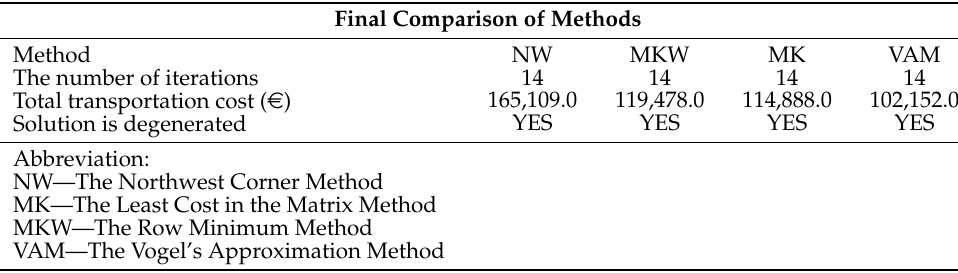
Table 8. Comparison of results obtained by using GNU Octave.